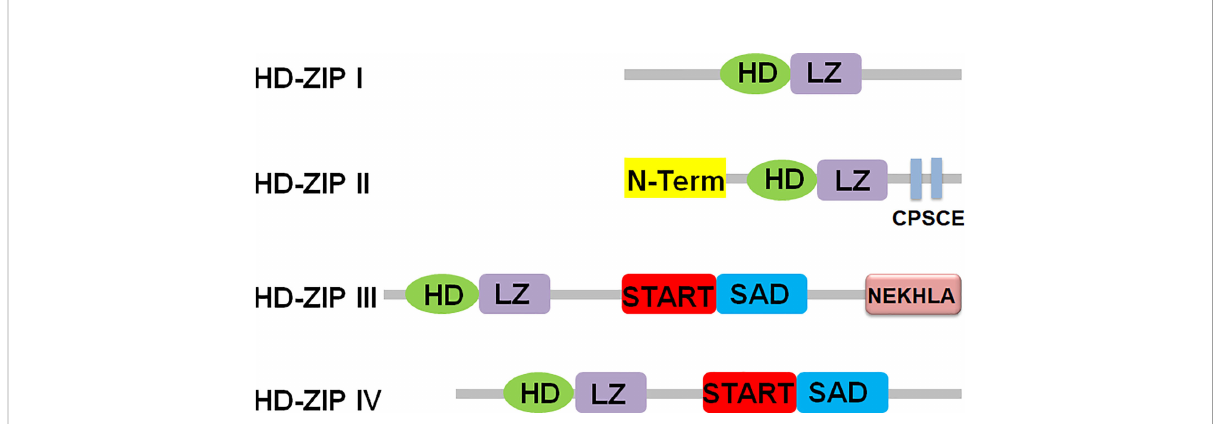
FIGURE 1 Schematic diagram of HD-ZIP family protein structure. HD, homeodomain; LZ, leucine-zipper; N-Term, N-term consensus sequence; START, steroidogenic acute regulatory proteinlipid transfer domain lipid transfer domain; MEKHLA, Met-Glu-Lys- His-Leu-Ala domain; SAD, START associated